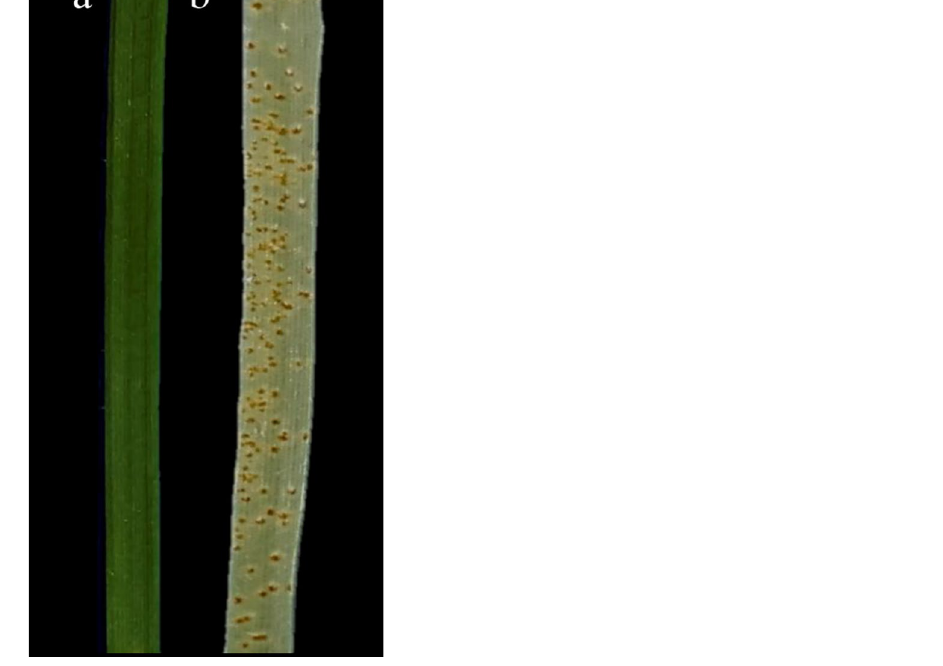
Figure 1. The response of Aegilops tauschii accessions AT349 and AT350 to Puccinia triticina pathotype CDHLQ at the seedling stage, ( a ) Resistant genotype (IT of ‘0 ;= ’), ( b ) Susceptible genotype (IT of ‘3 + ’), Photographed by Saeideh